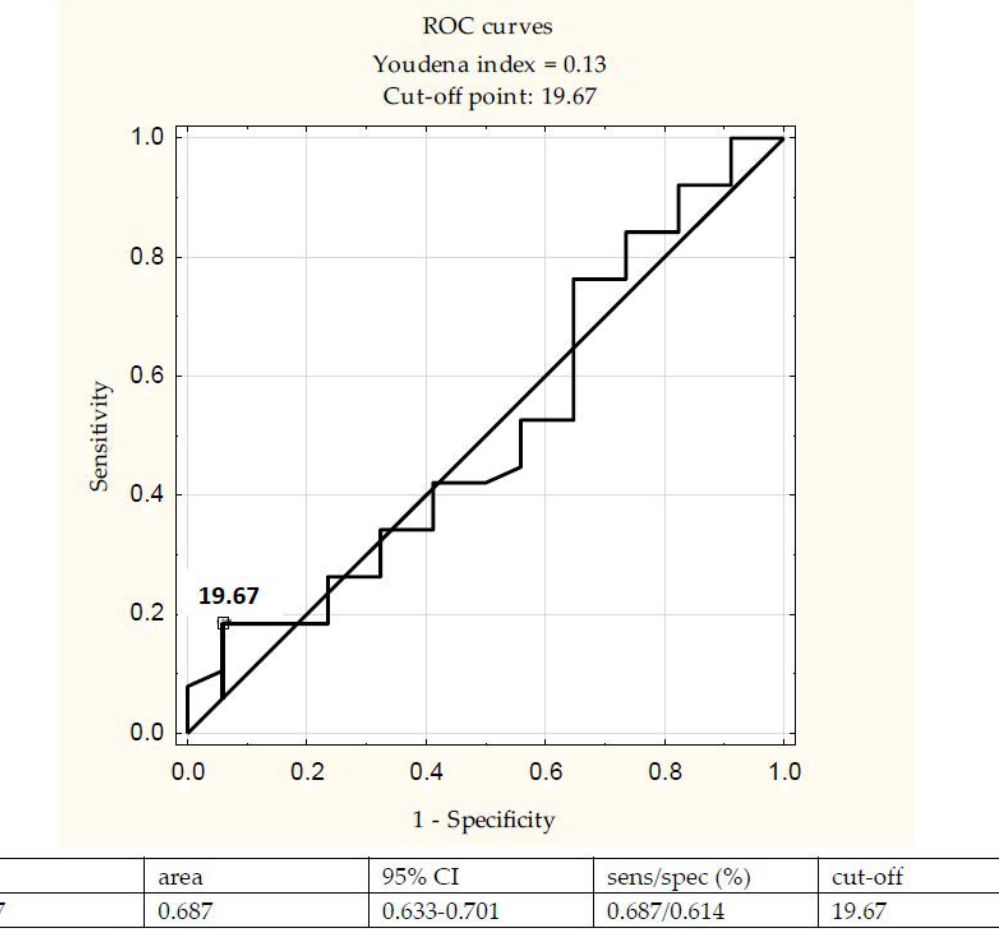
Figure 1. Receiver operating characteristics (ROC) curve of heat-shock protein 27 (HSP27) in predicting